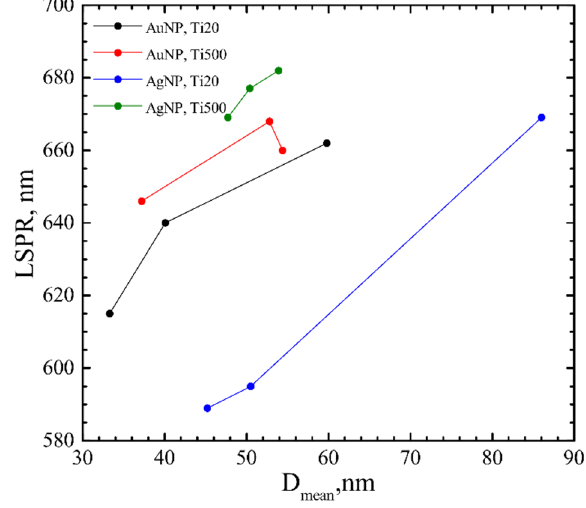
Figure 8. LSPR dependence on mean diameter ( D mean ) of AuNP and AgNP on TiO 2 thin films.